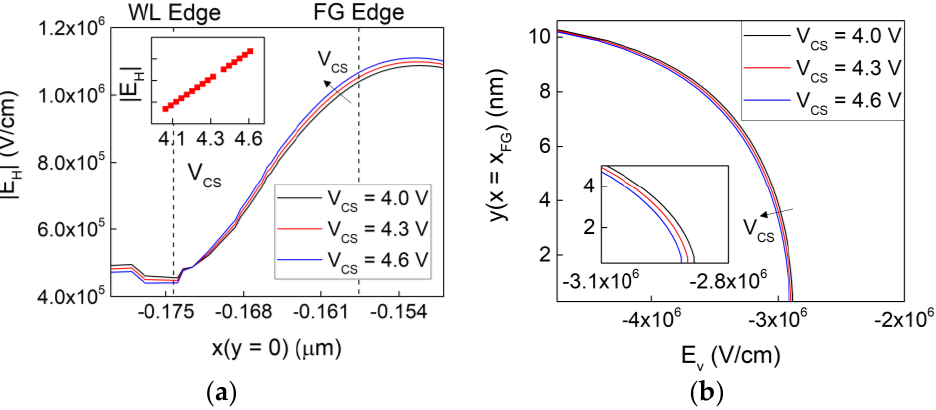
Figure 3. Technology computer-aided design (TCAD) simulations of the electric field with the common source (CS) voltage as a parameter. ( a ) The horizontal component is drawn against the x coordinate in y = 0, between the WL and the floating gate (FG) edges, the linearity being outlined in the inset. ( b ) The vertical component is drawn against the y coordinate in x = X FG , between the SiO 2 interface and the FG edge, the dependence on V CS being zoomed in the inset.